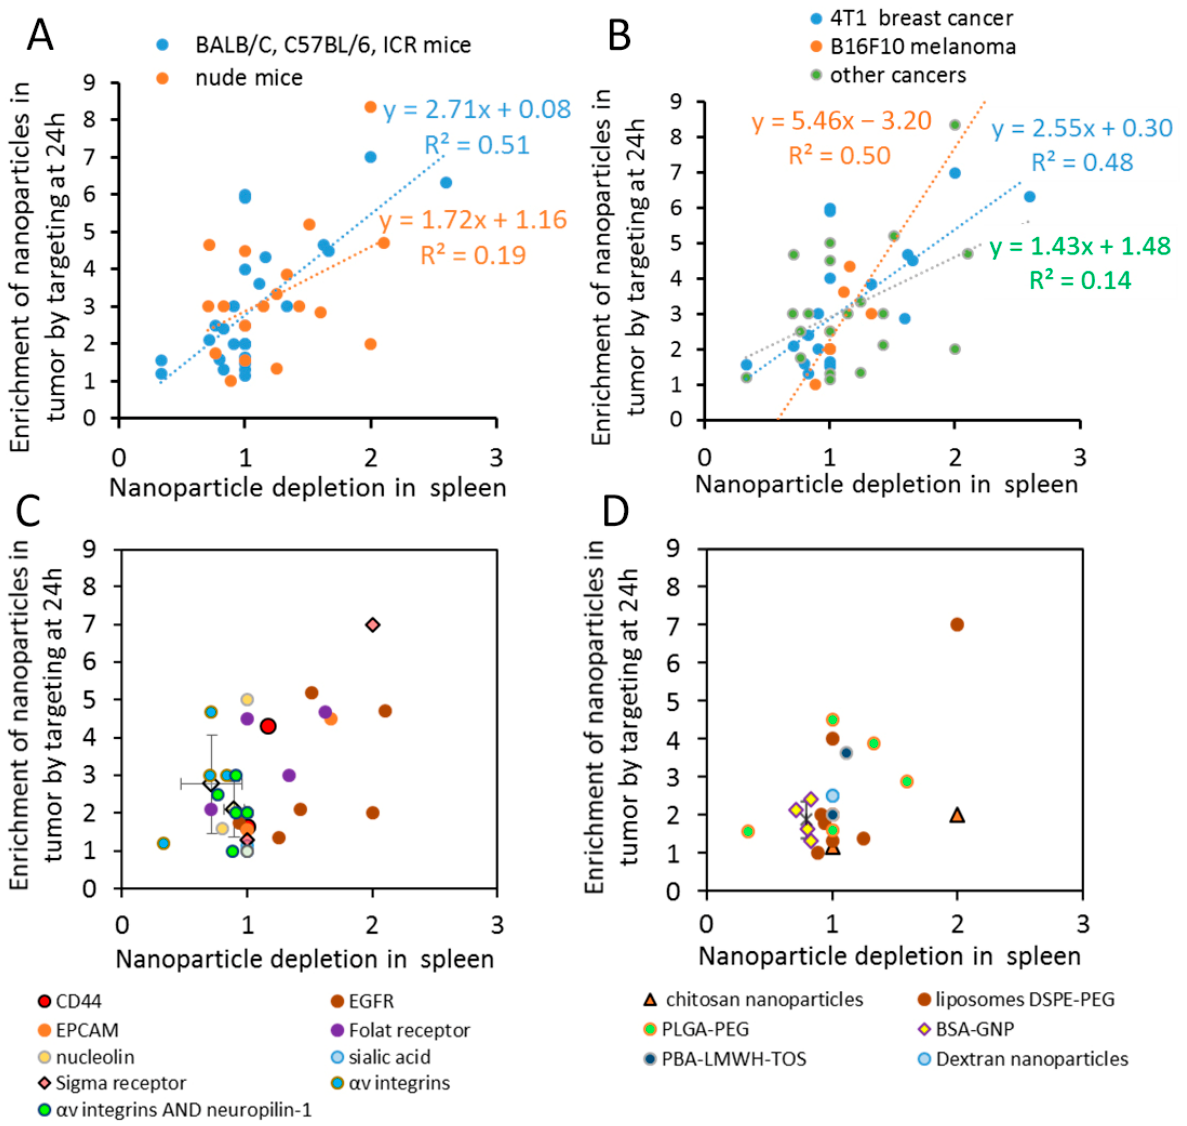
Figure 2. The positive correlation between accumulations of the nanoparticles in tumors and depletion in spleen is significant for the wild type mice and is more profound for integrin-targeting molecules or BSA-GNP nanoparticles. Nanoparticle ENT plotted vs. ratios of non-targeted to targeted nanoparticle concentrations in the spleen at 24 h after administration: ( A ) for different cancer types; ( B ) for either nude mice or mice with intact immune systems; ( C ) for targeted molecules that presented more than once in our dataset. Diamonds with error bars are averages for integrin-targeting RGD or iRGD peptides. Bars represent 95% confidence interval. ( D ) Nanoparticle types that presented more than once in our dataset. Bars represent 95% confidence interval for BSA-GNP. Notice that targeting of integrins and neuropilin-1 by iRGD peptide or applications of BSA-GNP are characterized by relatively low enrichment in tumors and accumulation in spleen, p < 0.05.